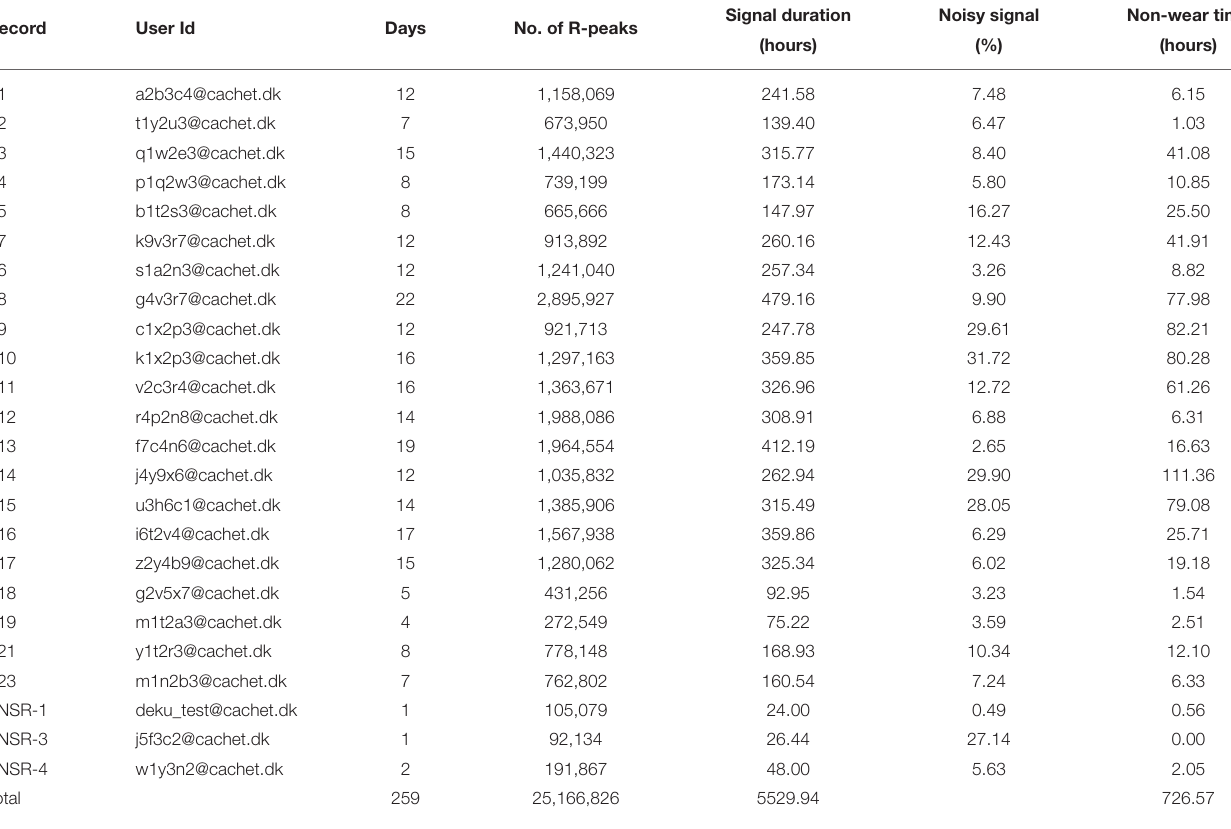
TABLE 8 | Signal quality assessments and detection of QRS complex/R-peaks. Non-wear Time: Time for which device was taken off (for changing, bathing, for any other